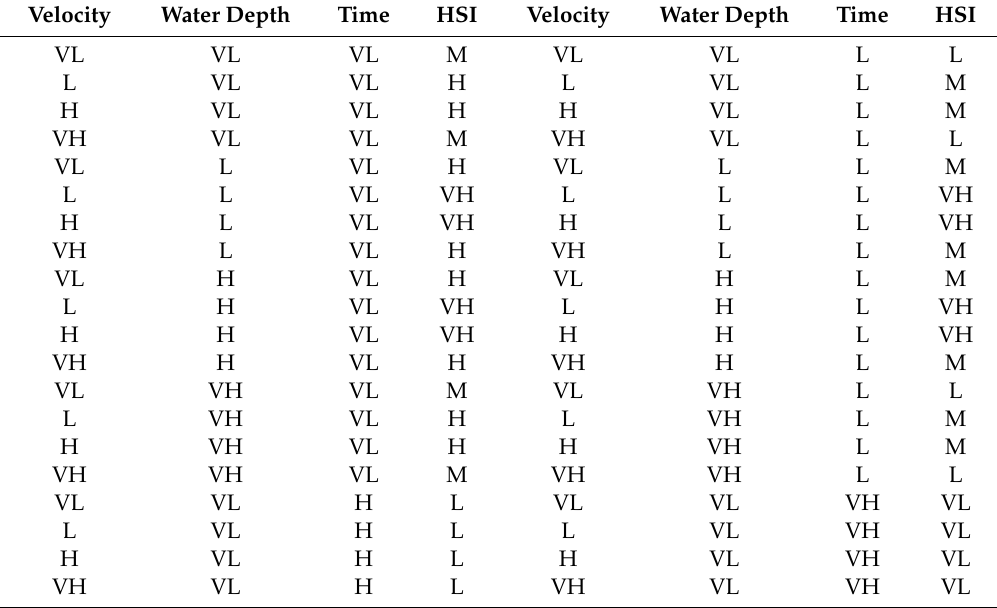
Table 1. Fuzzy rule base representing the habitat suitability index (HSI) for the spawning of Ctenopharyngodon idella ( C. idella